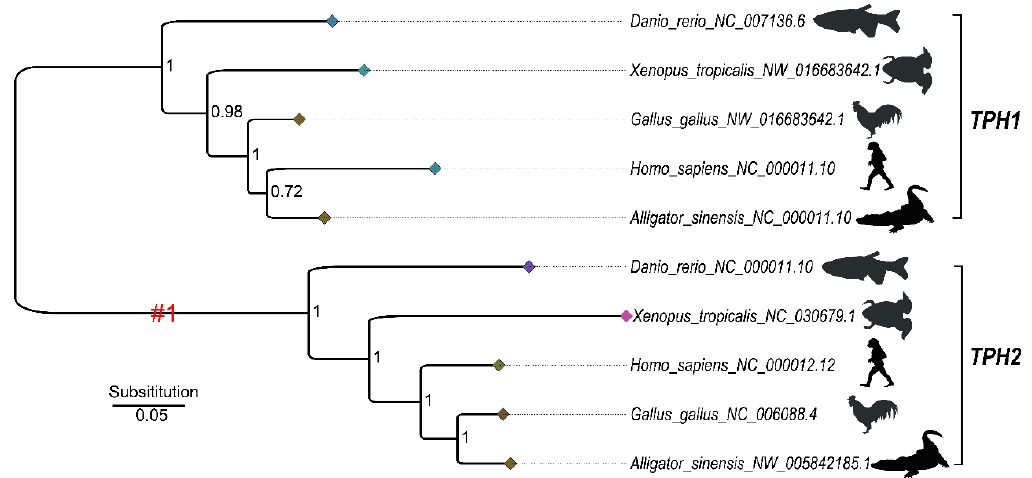
Figure 6. The Bayesian inference (BI) tree based on five TPH1 and TPH2 proteins selected from those shown in Figure S1 to represent the five major groups of vertebrates for selection pressure analysis. #1 denotes the foreground of the TPH2 clade. Numbers in the topology indicate the Bayesian posterior probabilities. The diamonds at the tips of each branch are colored based on the branch length, with a darker color representing a shorter evolutionary branch.